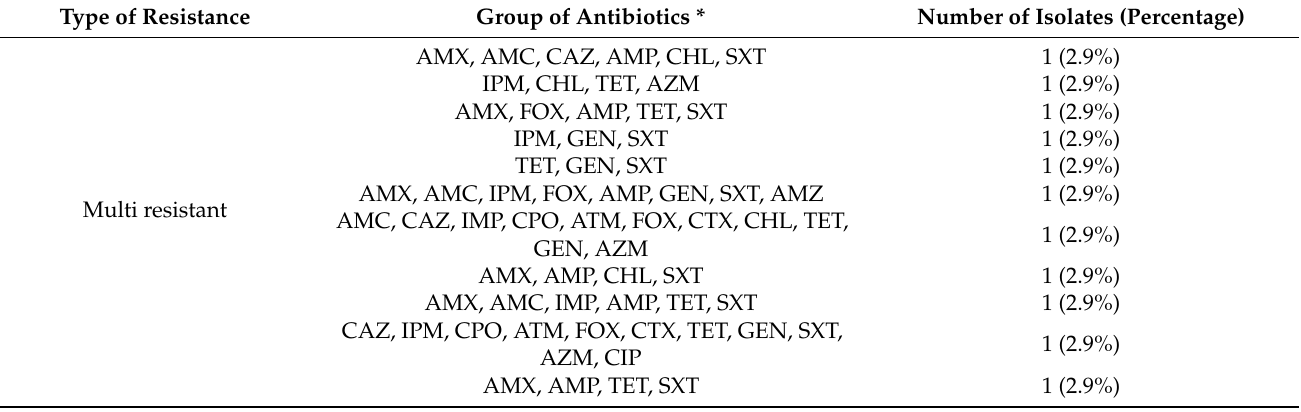
Table 7. Prevalence of multidrug resistance in a total of 30 non-susceptible Enterobacteriaceae . Type of Resistance Group of Antibiotics * Number of Isolates (Percentage)